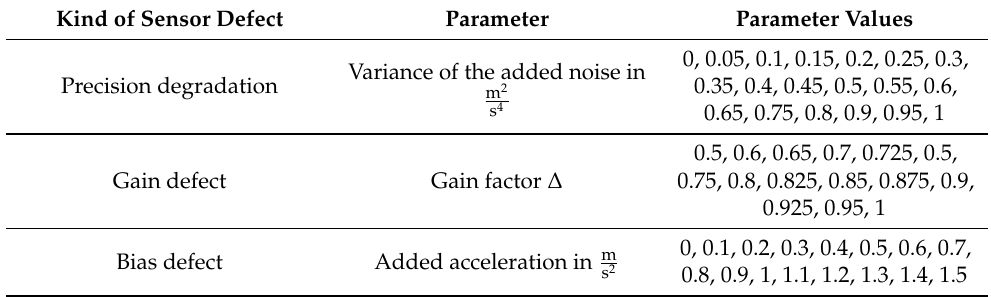
Table 2. Parameters of the simulated sensor defects.